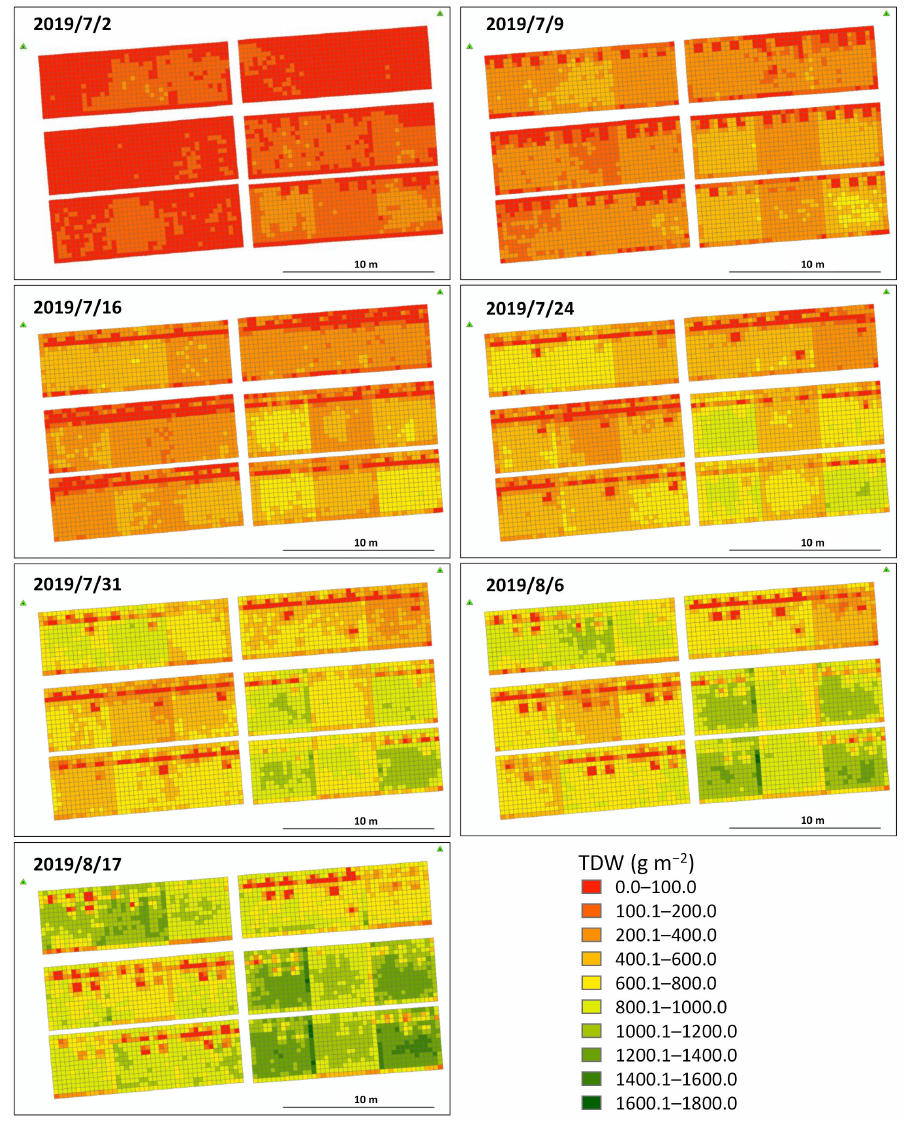
Figure 14. Example of spatial estimation of TDW in 2019 using the DSM model (greener areas represent higher biomass